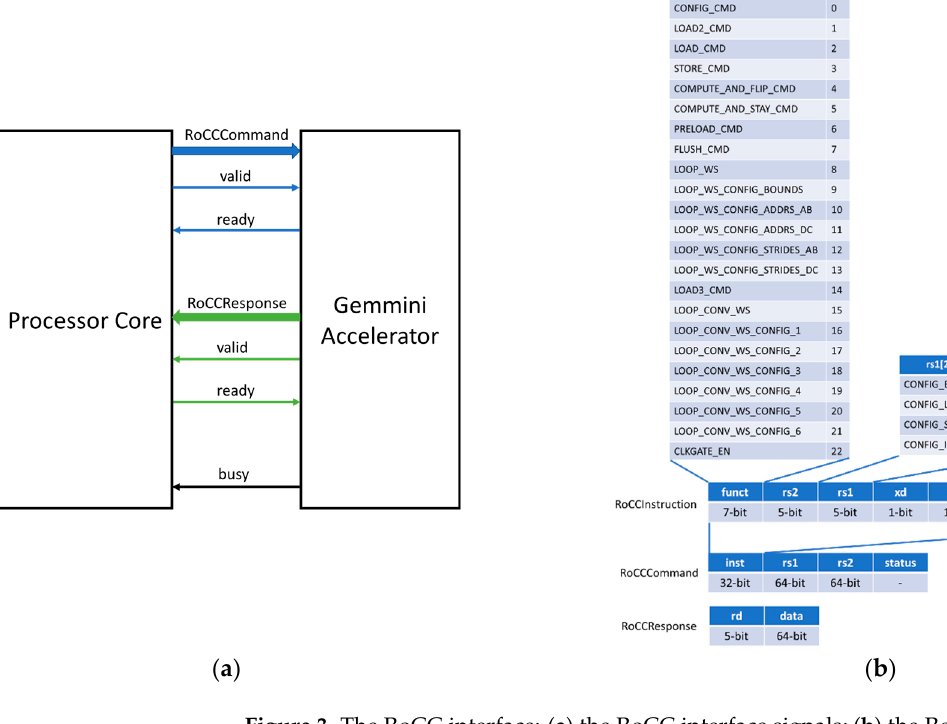
Figure 4. Command unrolling modules: ( a ) LoopConv module; ( b ) LoopMatmul module.